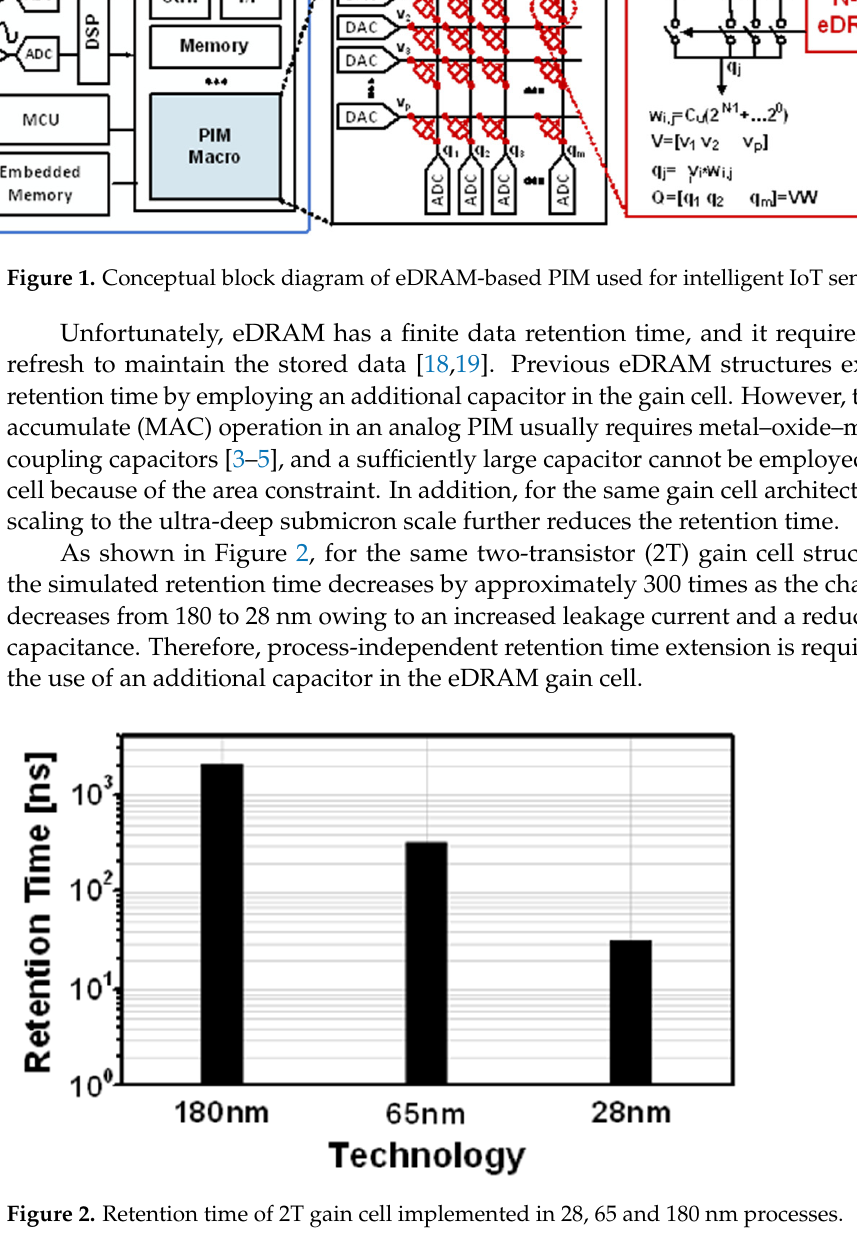
Figure 2. Retention time of 2T gain cell implemented in 28, 65 and 180 nm processes.